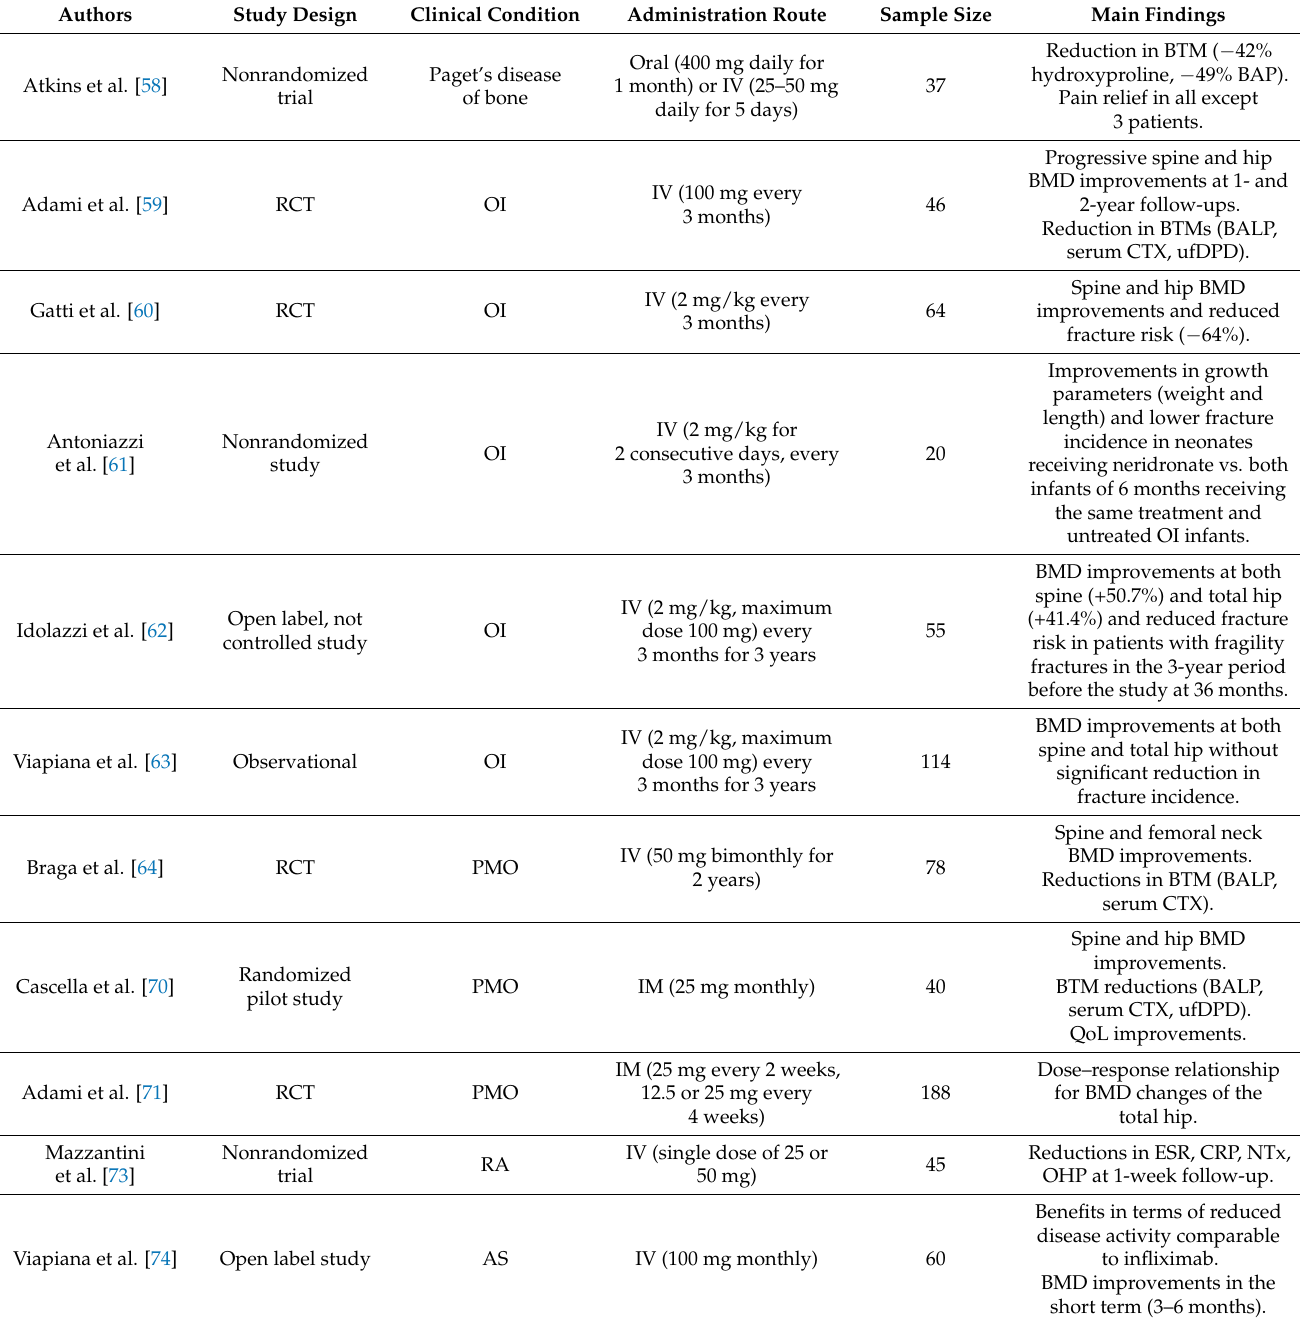
Table 1. Main findings from the studies investigating efficacy/effectiveness of neridronate in different clinical